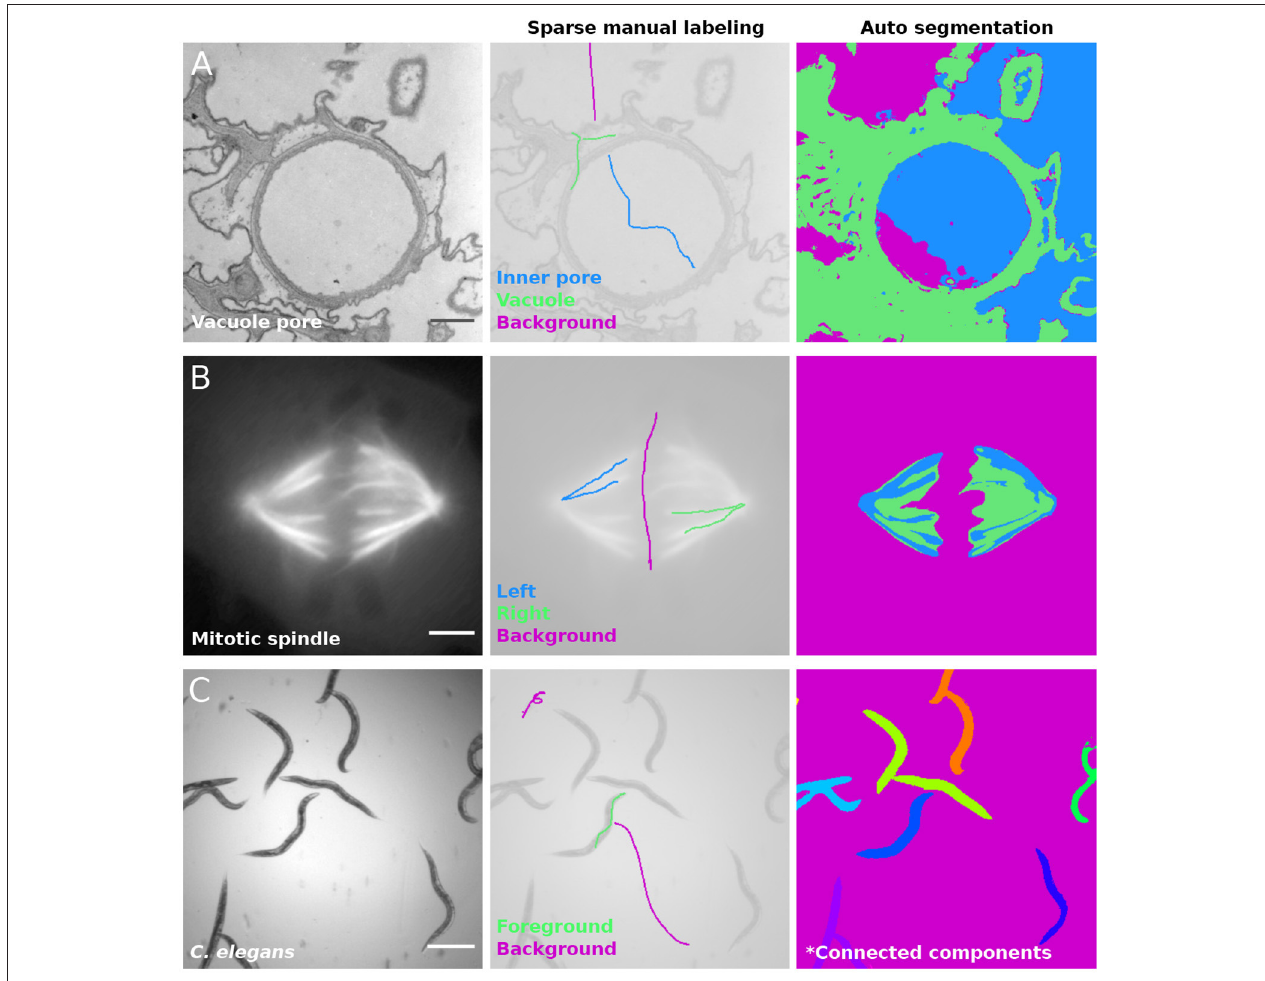
FIGURE 5 | Pixel classification failure modes: (A) Image of a contractile vacuole pore in paramecium caudatum acquired with transmission electron microscopy (left), in which inner pore (blue), cytoplasm (green) and background (magenta) were labeled with scribbles (center). LABKIT ’s classifier fails to distinguish background and inner pore classes (right). Image provided by Richard Allen (Cell Image Library, 38894). (B) Mitotic spindle of a Ptk2 cell expressing GFP-tubulin imaged in wide-field fluorescence (left). Left and right halves of the mitotic spindle are labeled in different classes (blue and green, respectively), while background is labeled in magenta (center). LABKIT ’s classifier is incapable of discriminating similar structures (right). Image provided by Sophie Dumont and Timothy J. Mitchison (Cell Image Library, 6568). (C) Bright field image of C. elegans (left), labeled with two classes (center): foreground (green) and background (magenta). After applying connected components analysis to the classification result, contiguous worms belong to the same object (right). Image provided by Fred Ausubel (Broad Bioimage Benchmark Collection, BBBC010). Scale bars (A) 500 nm, (B) 10 µ m, and (C) 500 µ